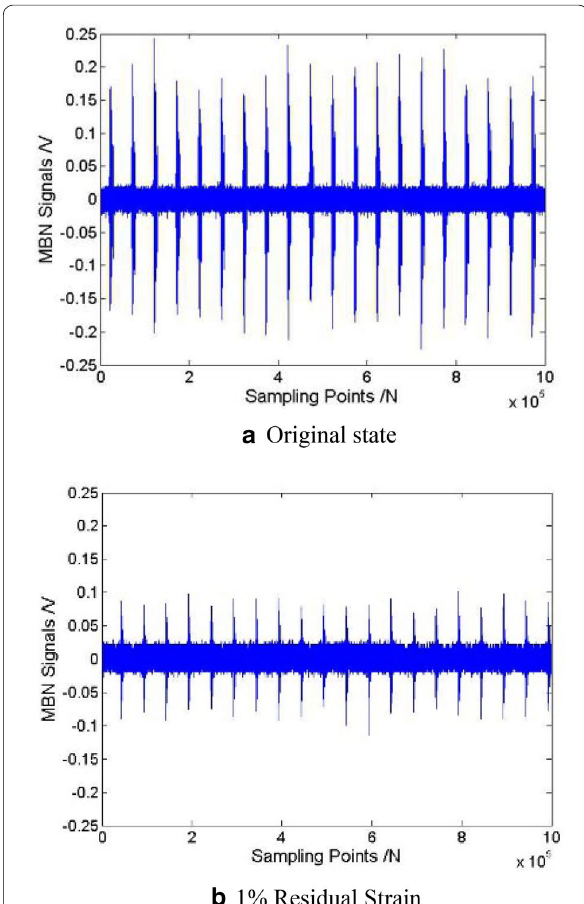
Figure 3 Typical MBN signals of the specimen